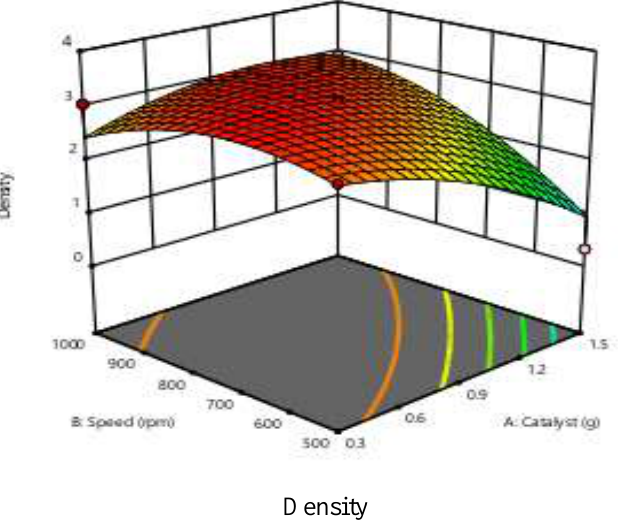
Figure 3: Scatter diagram: (a) yield; (b) specific gravity; (c) density with the corresponding 3D surfaces.